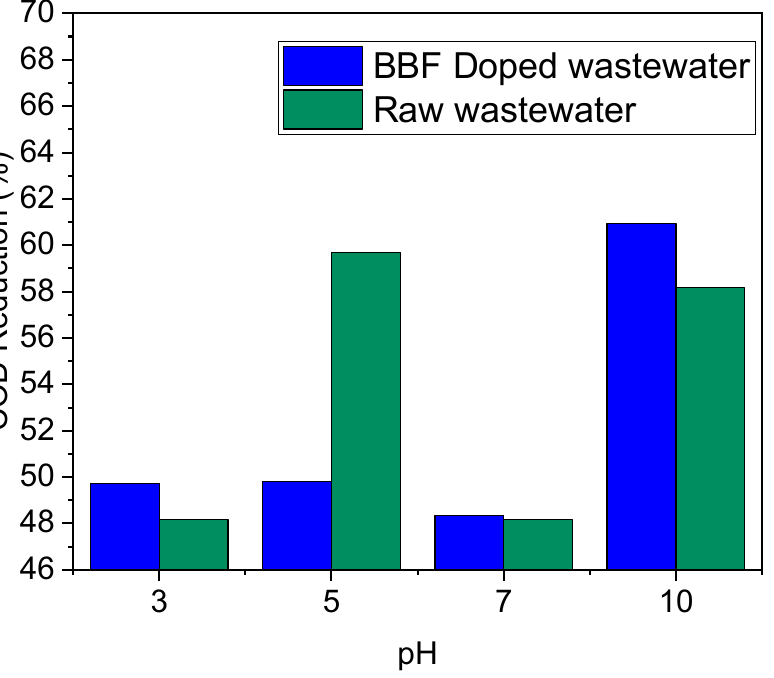
Figure 4. Evaluation of the effect of pH on the COD reduction rate of industrial discharges: ∆ P = 4 bar; [COD] wastewater = 180 mg of O 2 /L; [BBF] = 40 mg/L; [COD] doped wastewater = 220 mg of O 2 /L; Turbidity wastewater = 20 FNU; Turbidity BBF doped wastewater = 28 FNU; and treatment time = 15 min.